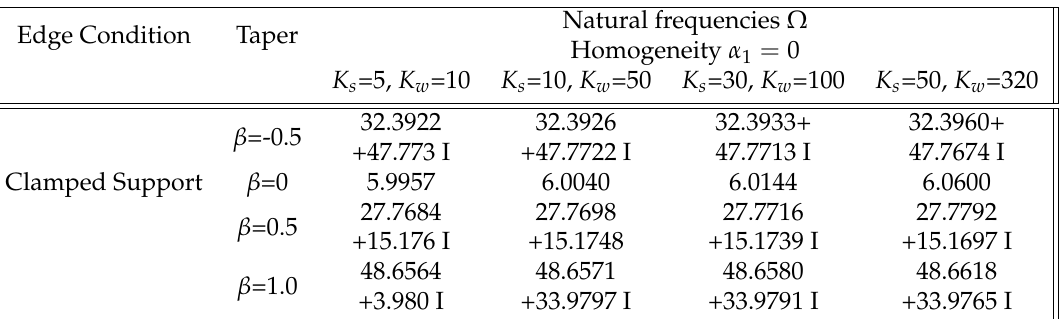
Table 8. Influence of taper on natural frequency of combine foundations parameter coefficients